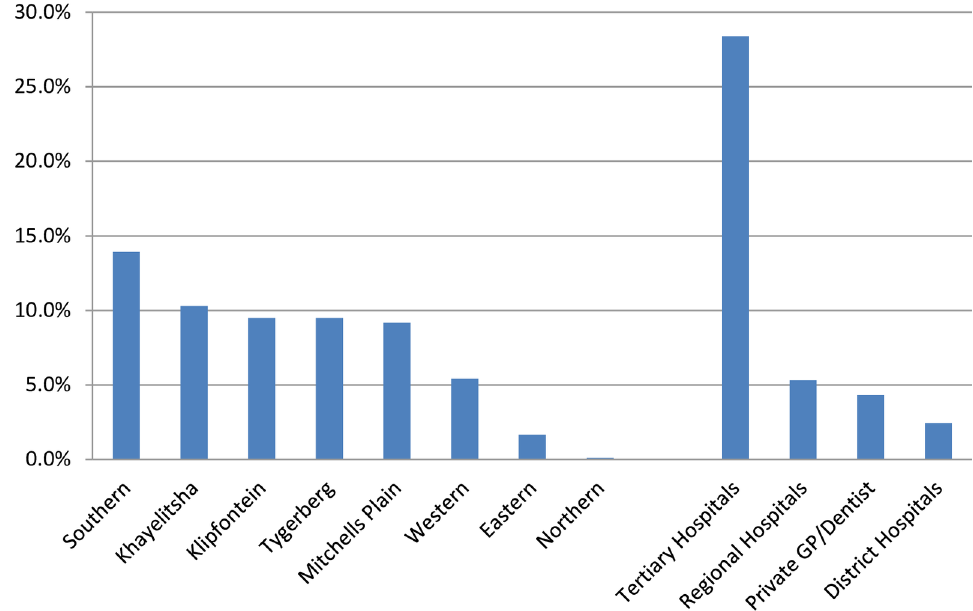
Fig 1. Sign Language Interpreter-assistedhealth care visits to sub district primary healthcare facilities and hospitals (2008–2013).